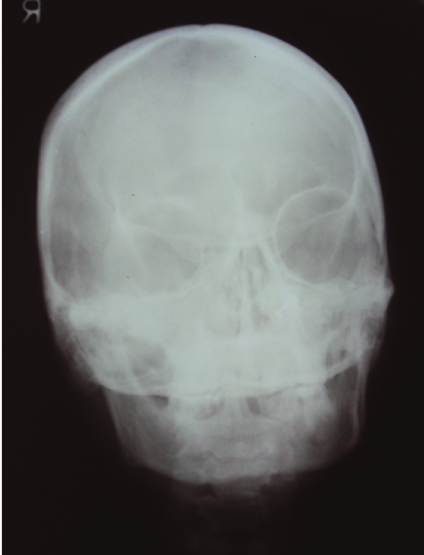
Figure 6: PA view of skull.